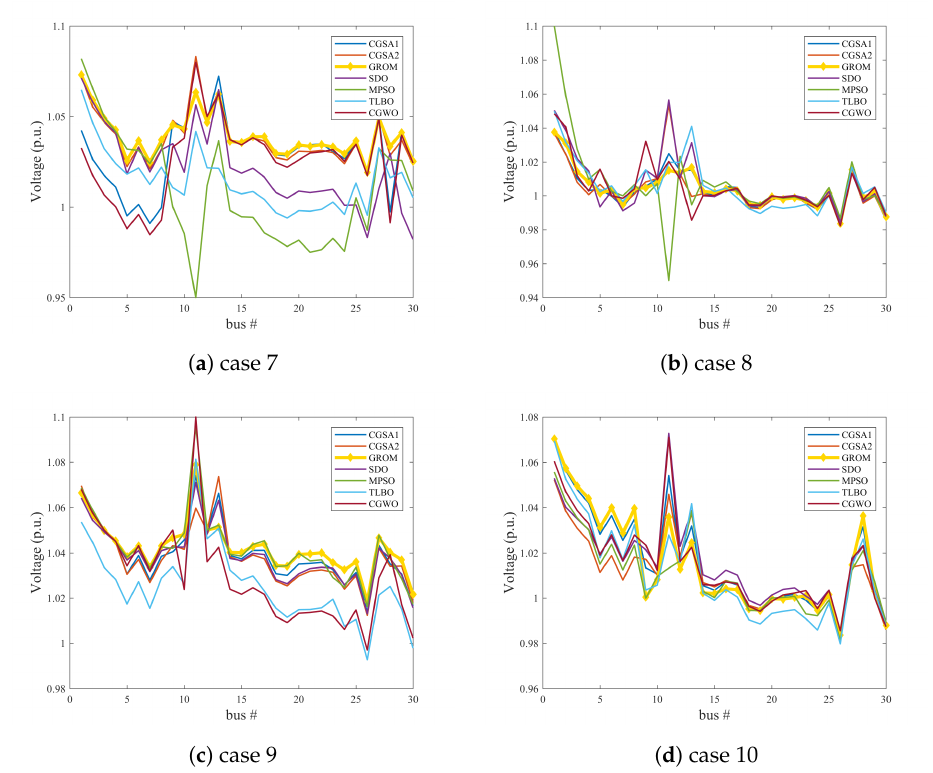
Figure A4. Voltage Profile for multi-objective optimal power flow.